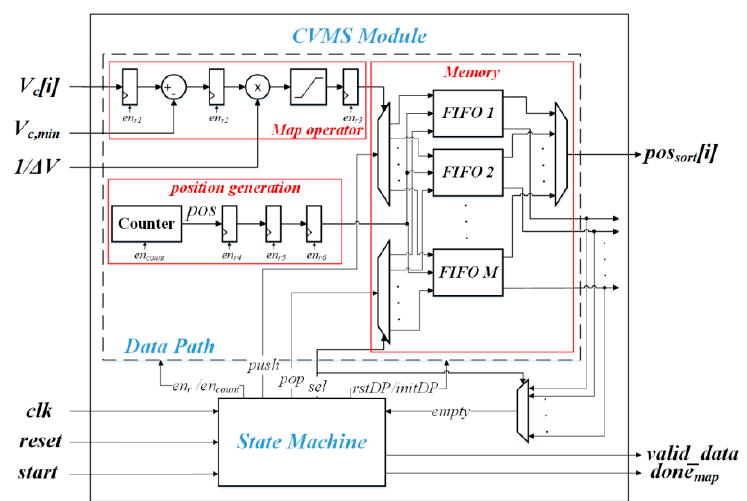
Figure 10. Hardware architecture of the developed system.